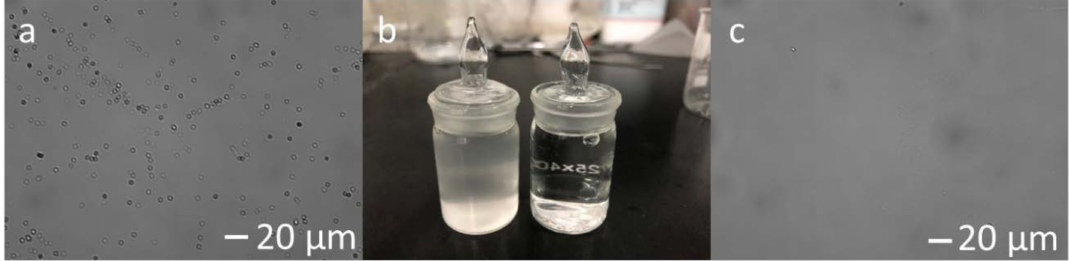
Figure 10. The beaker with oil-in-water emulsion (left-hand side in ( b )), the beaker with water filtered through the membrane S1350-1650 at 0.1 MPa, 2.5 L/min (right-hand side in ( b )), and the corresponding images from an optical microscope of the emulsion ( a ) and the filtered water ( c